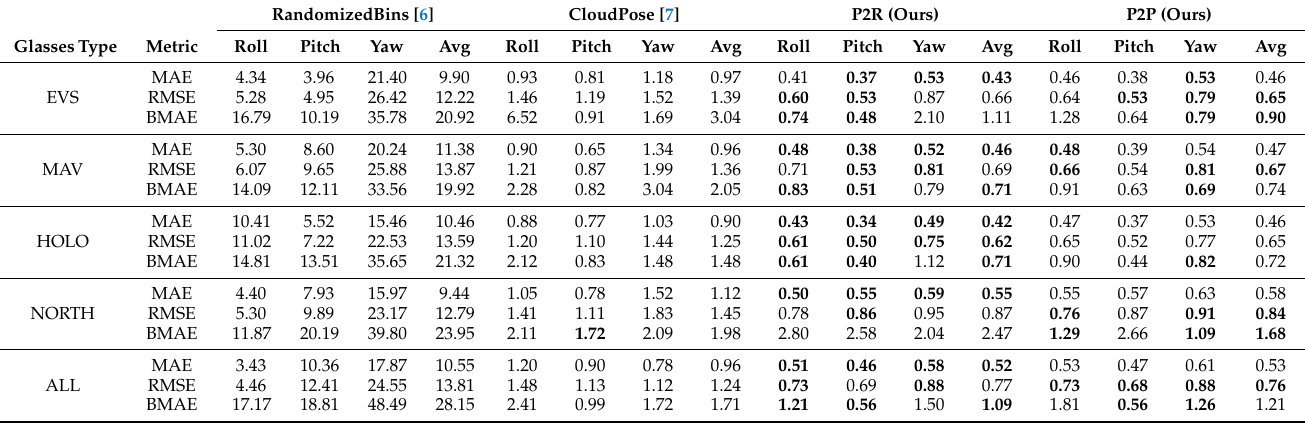
Table 3. Orientation results of the P2R and P2P approaches compared to RandomizedBins and CloudPose on the given error metrics in degrees. The Everysight Raptor is referenced as EVS, Hololens 1 as HOLO, North Focal Generation 1 as NORTH and the Mini Augmented Vision glasses as MAV. ALL stands for all glasses combined. The roll, pitch, yaw and the average of all three axes are given on the defined metrics. The lowest values among all methods per metric on each individual axis is